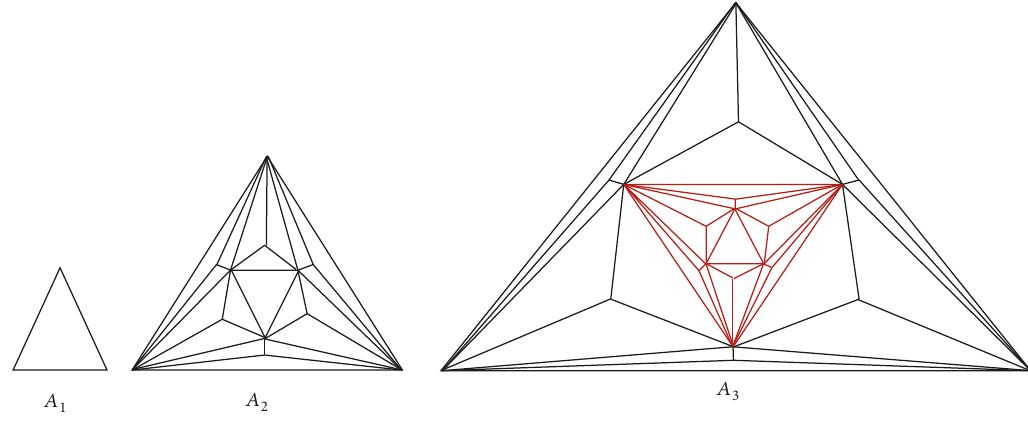
Figure 3: The first three graphs of 𝐴 𝑛